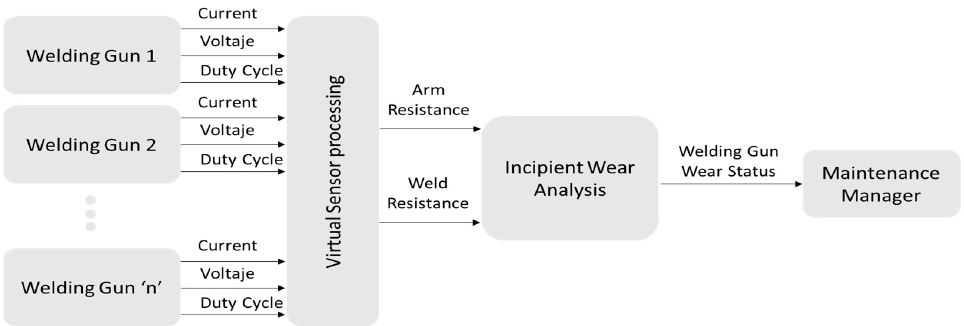
Figure 12. Flow diagram of the operation of the incipient wear detection system in welding guns.